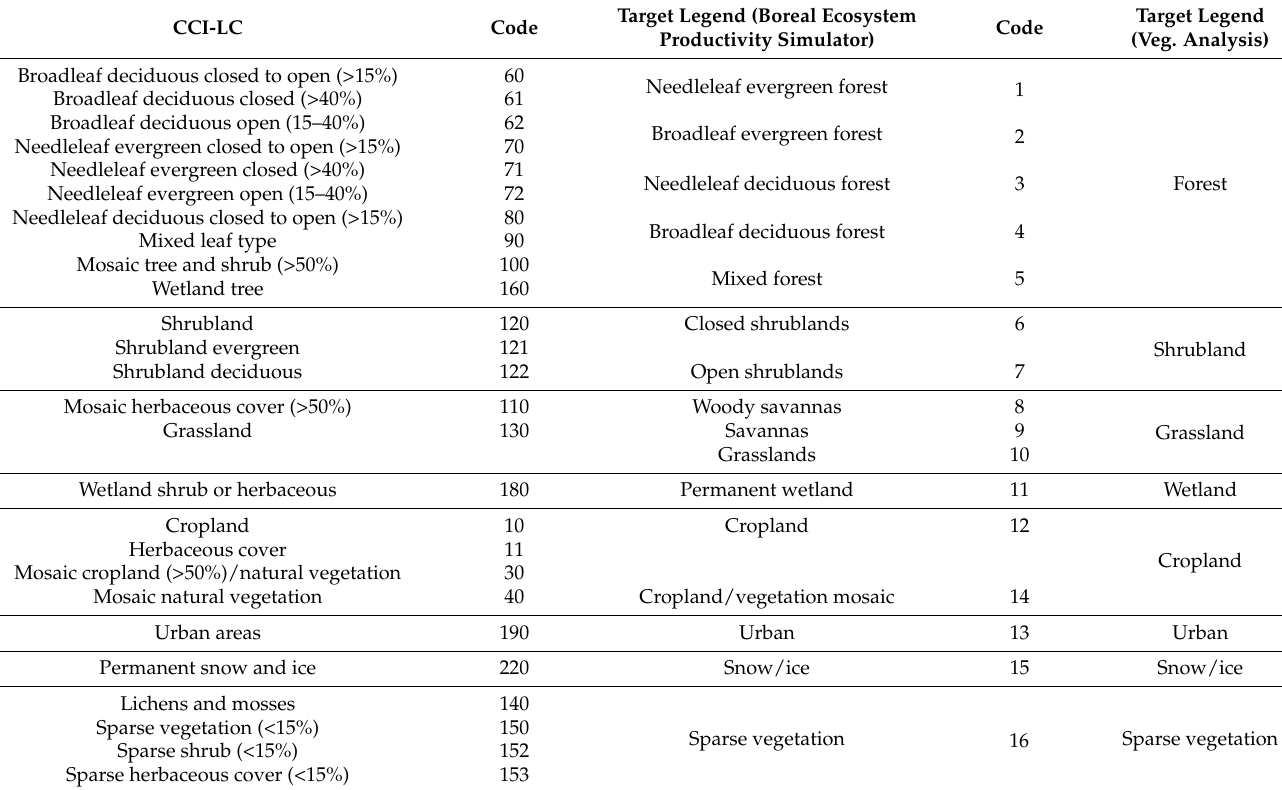
Table 1. Generalized regional land-cover legend